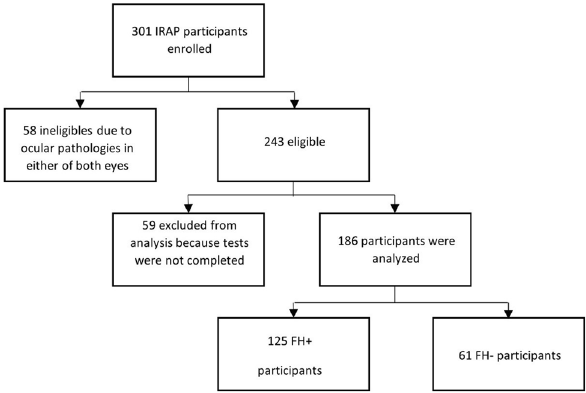
Figure 3. Flow chart of the study recruitment.